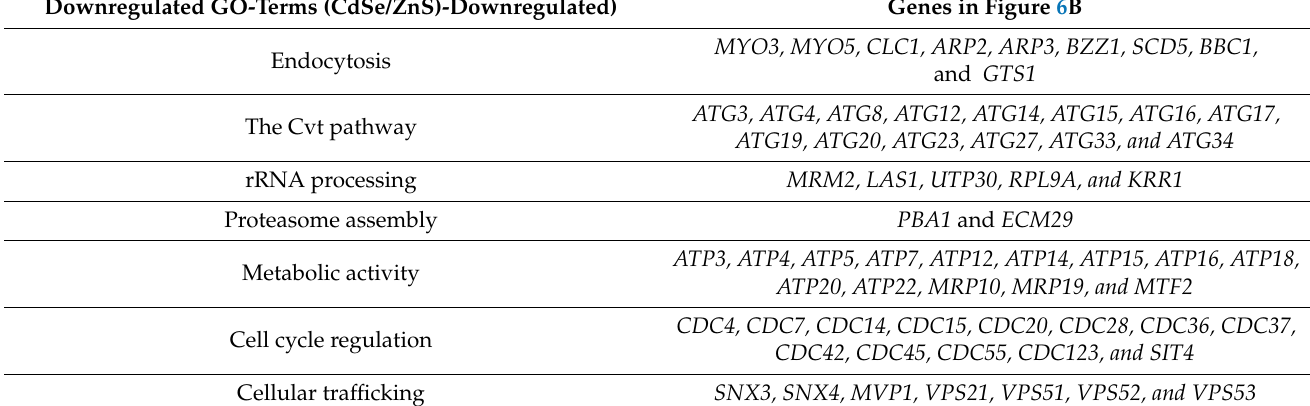
Table 4. A table listing the GO-terms and genes in Figure 6B. It represents the multiple downregulated cellular processes and genes in yeast exposed to 10 µ g/mL CdSe/ZnS QDs. All genes incorporated in this table exhibited expression levels significantly lower than expression levels of NTC